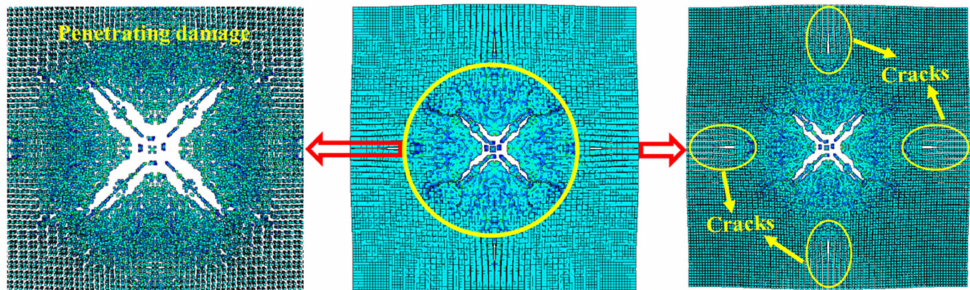
Figure 23. Failure states of polyurethane sacrificial cladding in the SPH–FEM coupling model.